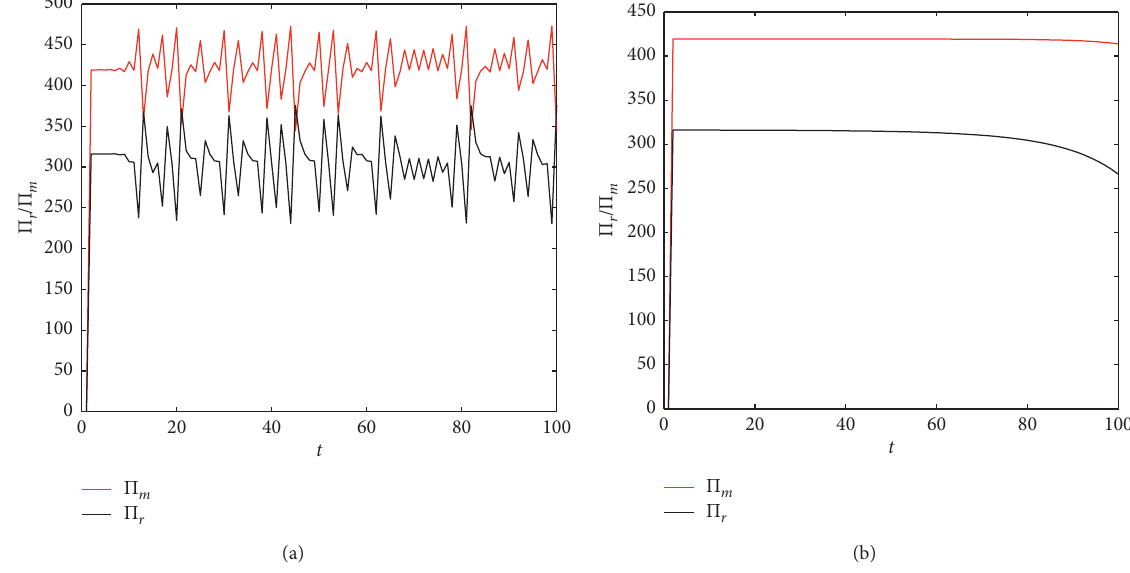
Figure 15: Time series of 􏽑